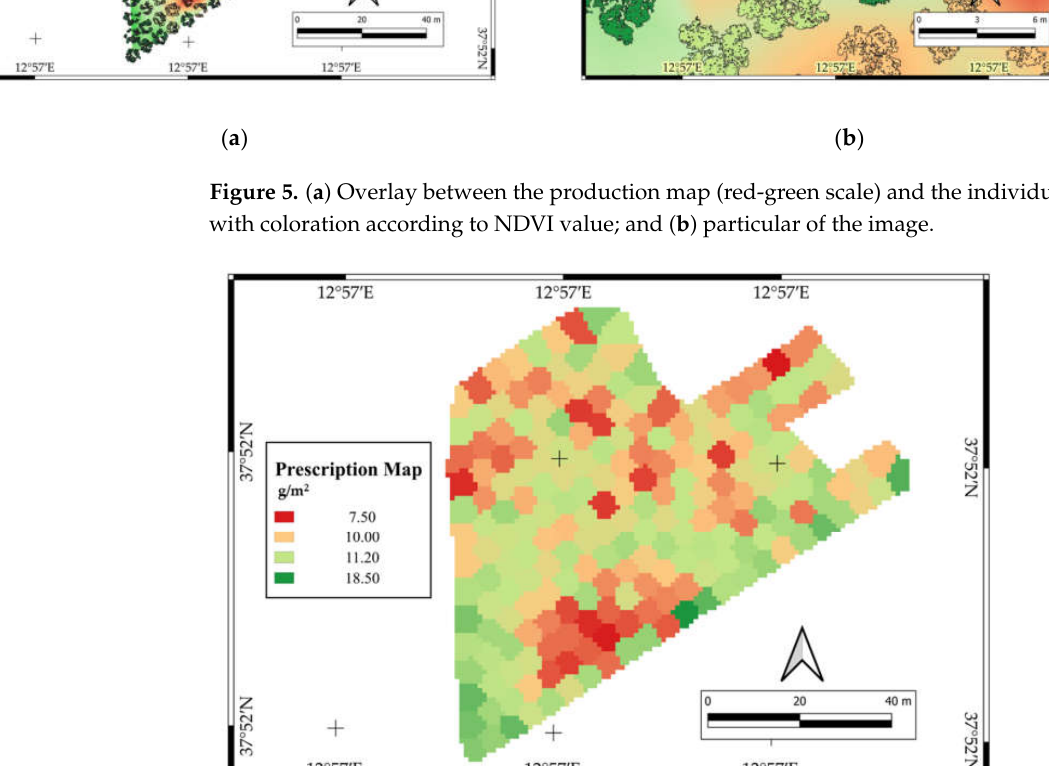
Figure 6. Prescription map of nitrogen fertilization according to the different quantity of nitrogen per square